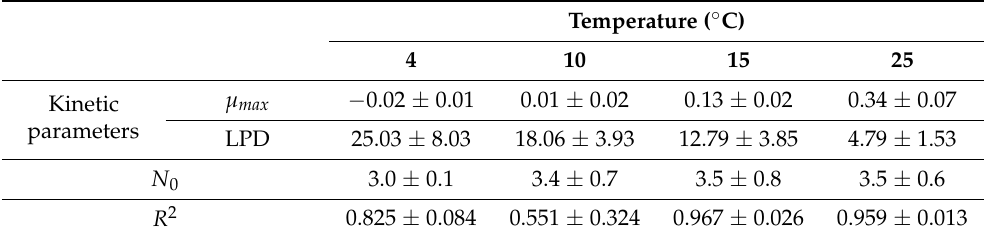
Table 1. Baranyi model kinetic parameters for Salmonella spp. in chicken and duck.